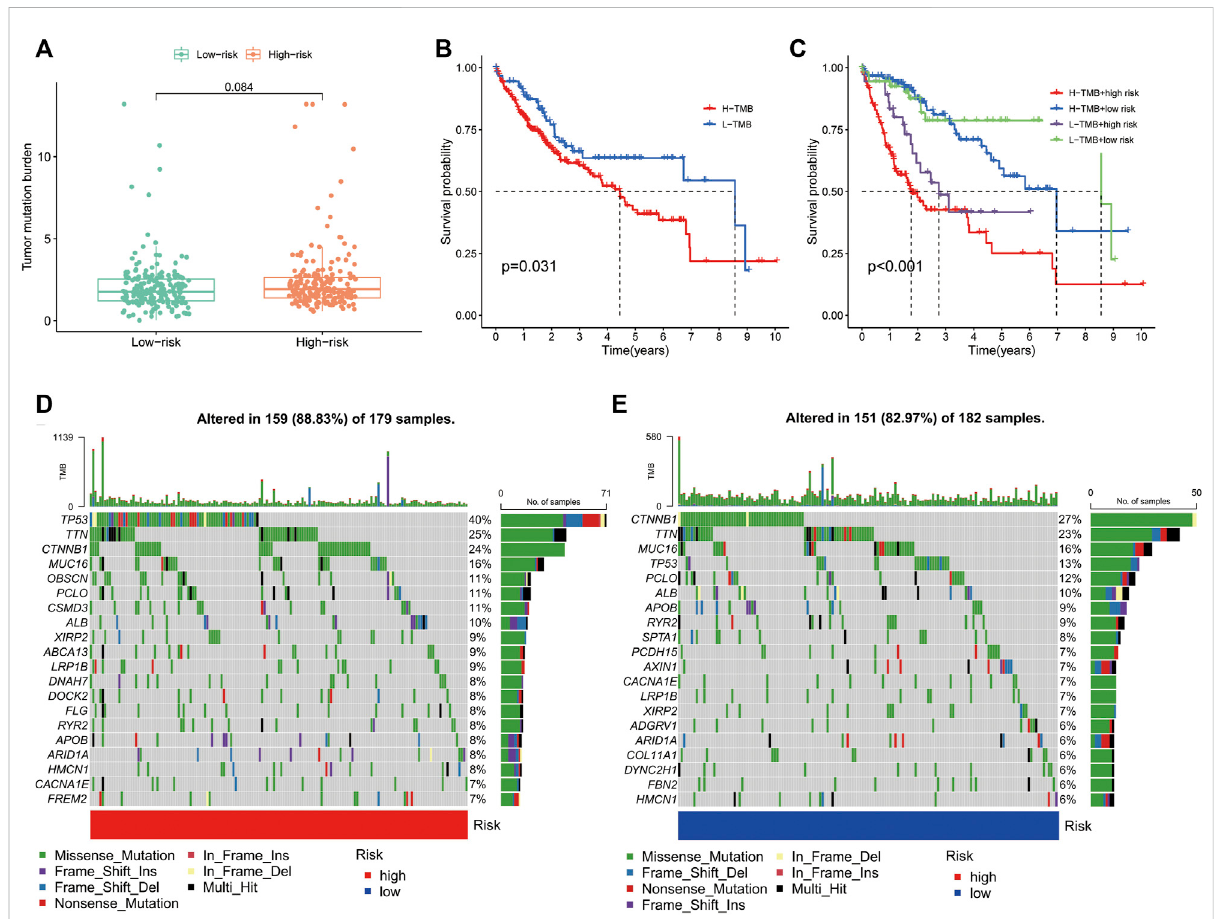
FIGURE 9 Correlationoftheimmune-relatedgenesignaturewithtumourmutationburden(TMB)inhepatocellularcarcinoma. (A) ViolinplotofTMBinthe high- and low-risk groups. (B) Kaplan – Meier curve of high-TMB and low-TMB. (C) Kaplan – Meier curve of the patients in the high- and low-TMB groups combined with the high- and low-risk groups. (D) Mutant gene waterfall plot in the high- and (E) low-risk